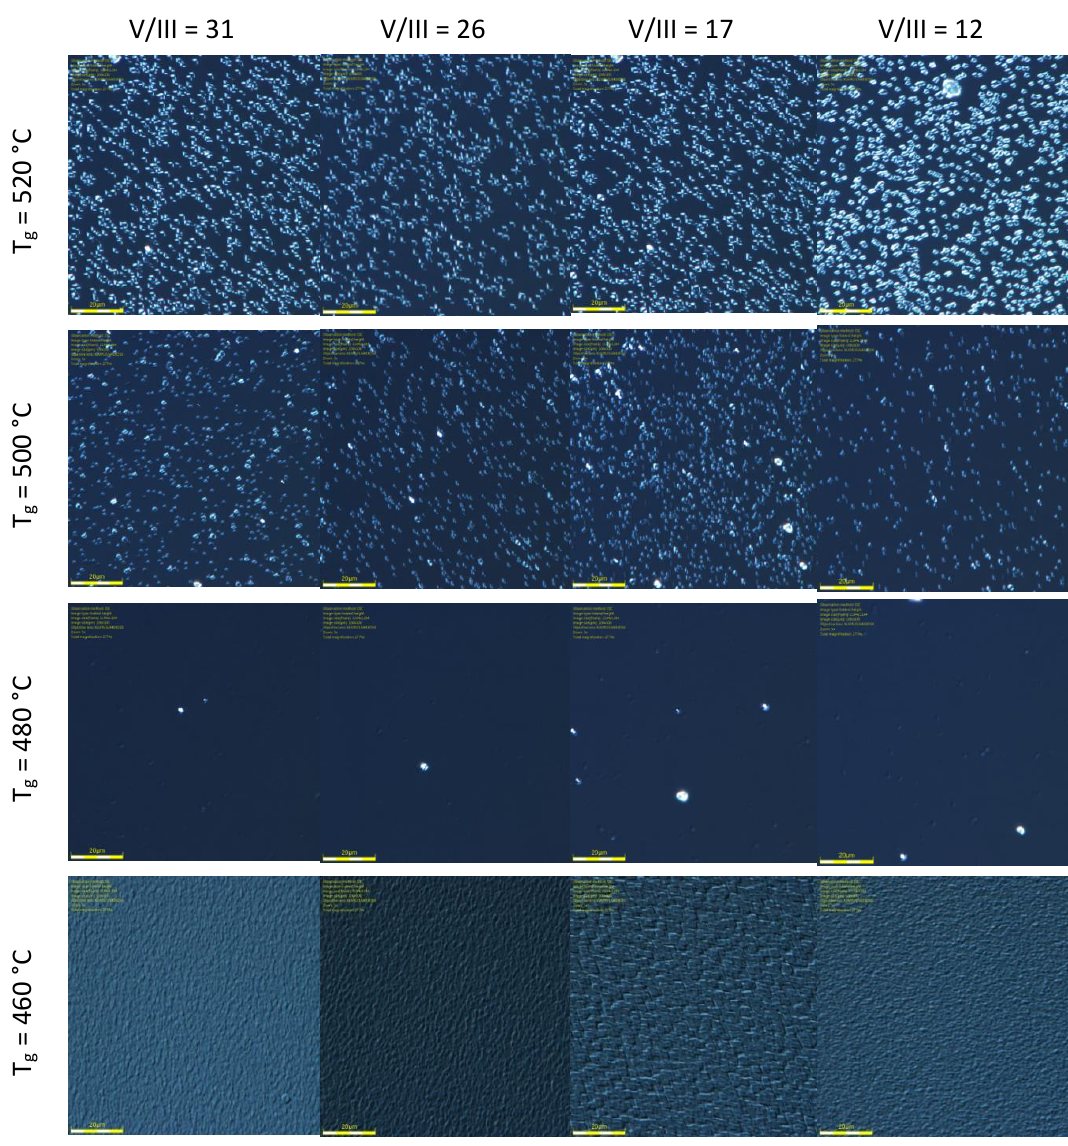
Figure 4. Matrix of optical microscopy pictures (Nomarski contrast) of 0.1 × 0.1 mm 2 surface area of 2.5 µ m thick InAlAs / InP test samples shown versus MBE growth parameters. The rows are for constant substrate temperature and columns are for constant V / III ratio.